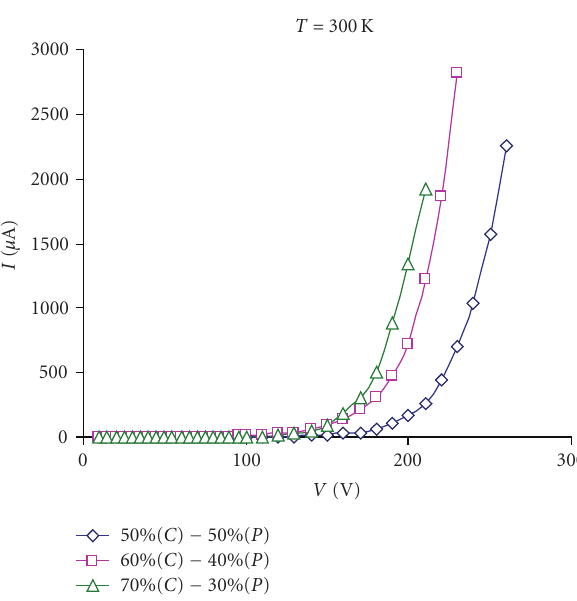
Figure 4: The I-V characteristic for samples no.2, no.3, and no.4 at room